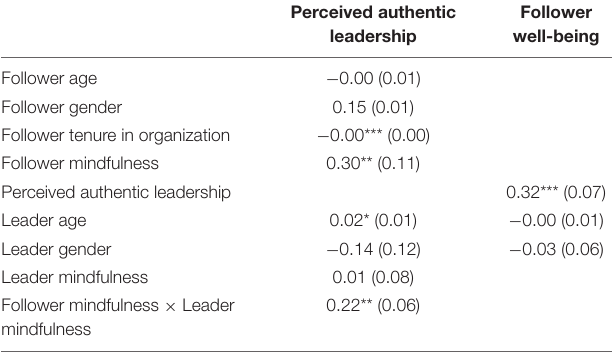
TABLE 3 | Results of multilevel path